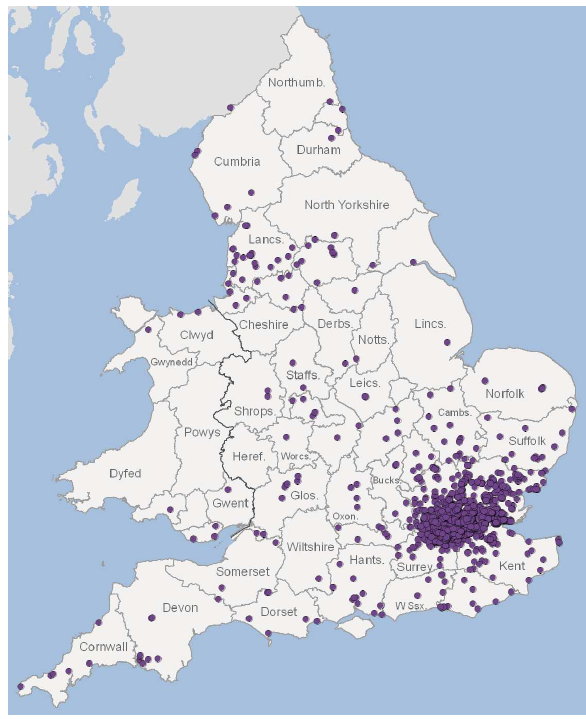
Figure 3. Apparent Distribution of the Authority's Workforce